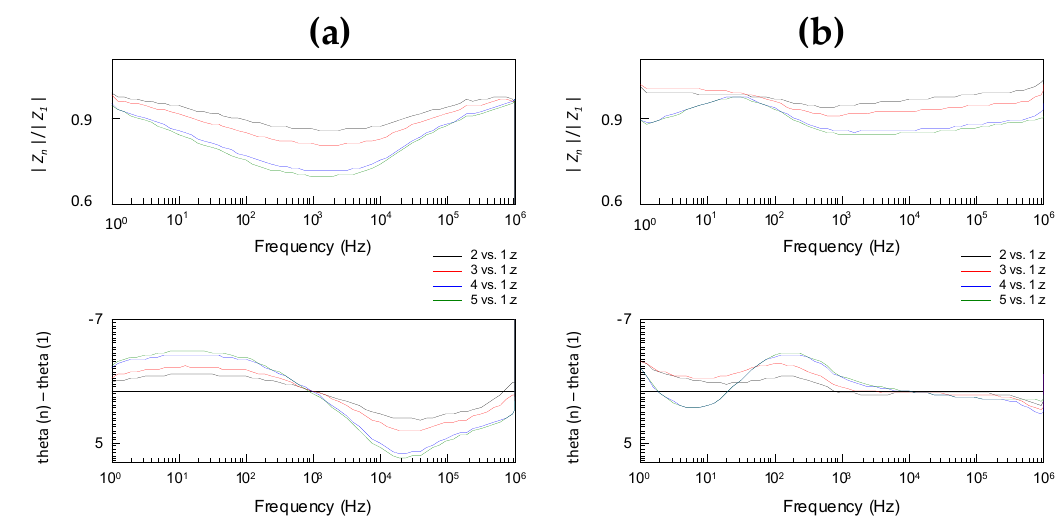
Figure 4. The complex division of bioimpedance spectroscopy (BIS) spectra for the same ( a ) cucumber and ( b ) tongue sample using the inner configuration shows the clear time-variant nature of the measurements. A total of five repeated scans were performed, and here the subsequent measurement is compared to the first one.